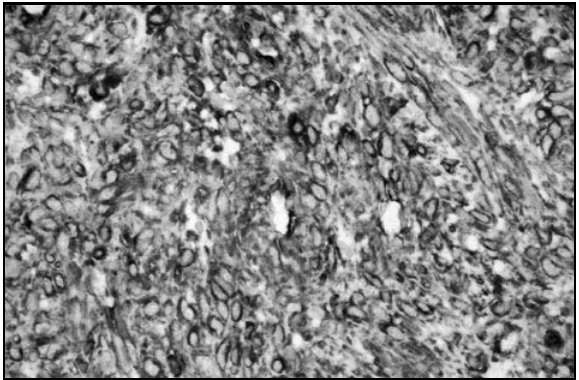
Figura5 – Reação imuno-histoquímica positiva para vimentina (imuno-histoquímica, estreptavidina-biotina-peroxidase – aumento original 400 vezes)